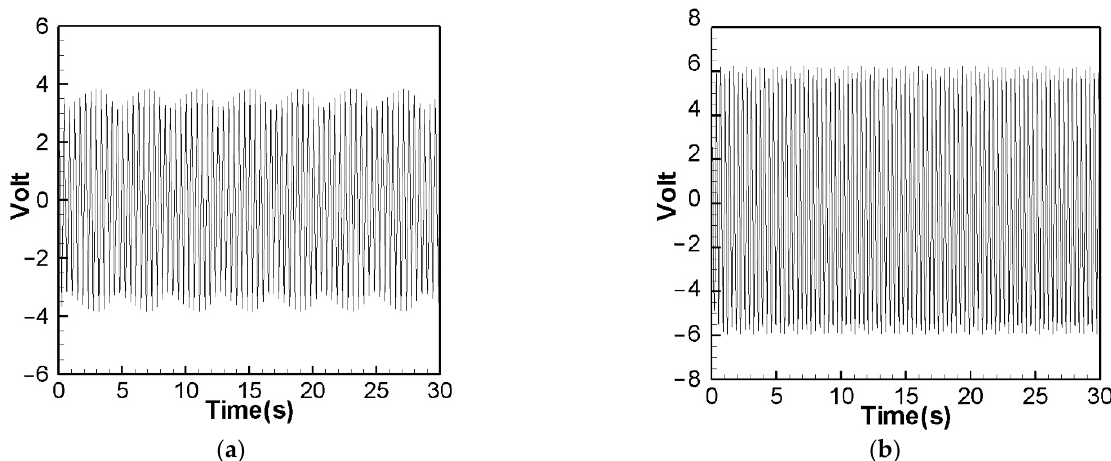
Figure 15. Experimental voltage output for “linear” frequency excitation. ( a ) 1st mode, ( b ) 2nd mode.